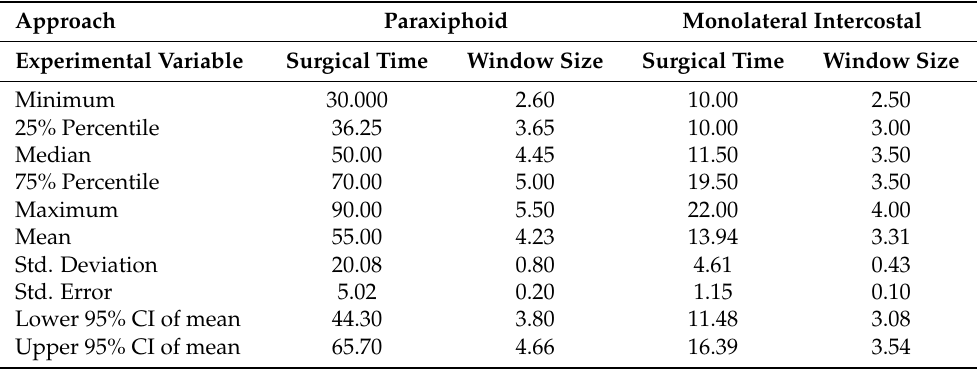
Table 1. Statistic column analysis for the investigated variables (surgery time and window size) in each experimental surgical approach (paraxiphoid and monolateral intercostal).